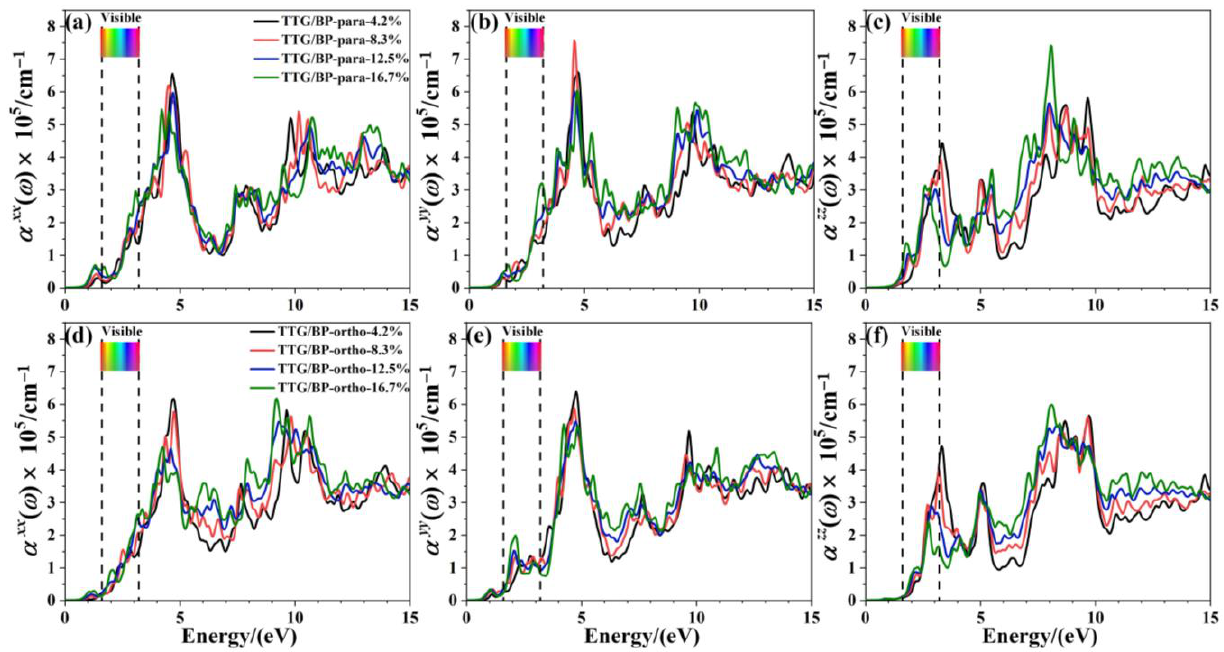
Figure 8. Absorption coefficient of TTG/BP system with different doping concentrations. ( a ) α xx of TTG/BP-para; ( b ) α yy of TTG/BP-para; ( c ) α zz of TTG/BP-para; ( d ) α xx of TTG/BP-ortho; ( e ) α yy of TTG/BP-ortho; ( f ) α zz of TTG/BP-ortho.